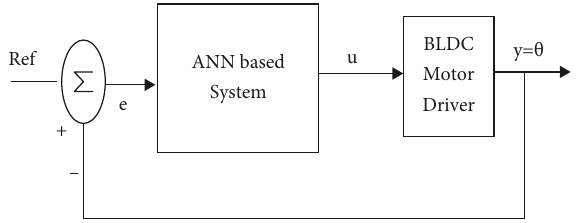
Figure 9: Supervisory control algorithm for the system.